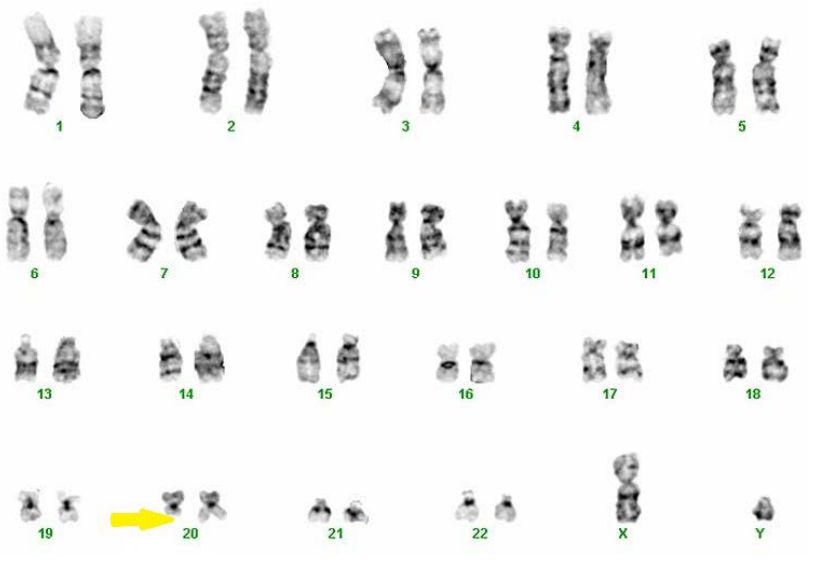
Figure 2. Karyotype 46, XY,